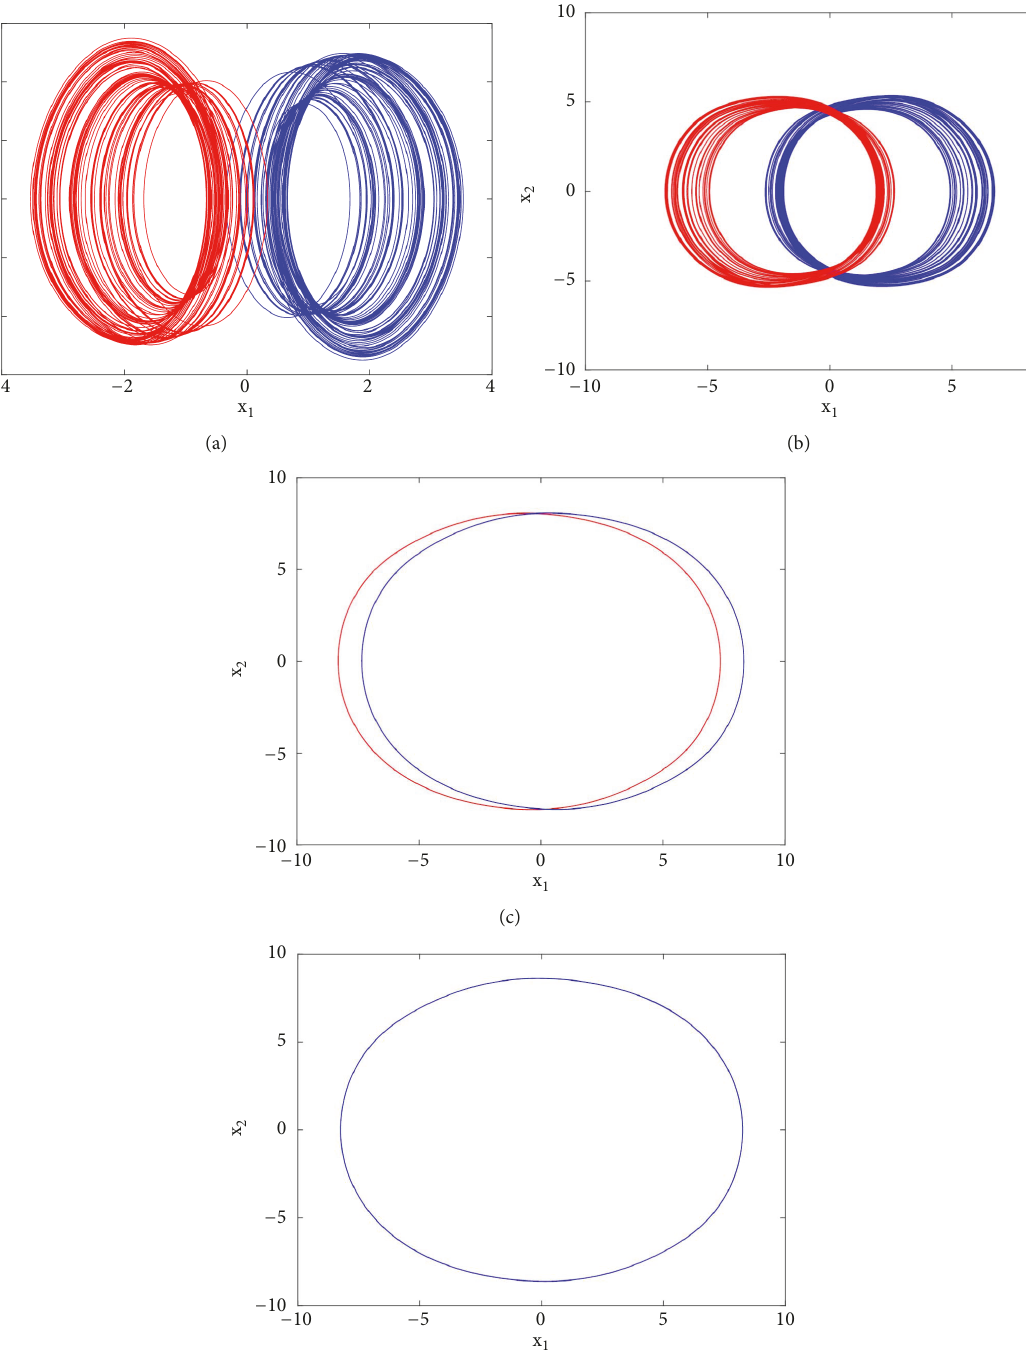
Figure 13: Coexistence of seven disconnected attractors (two pairs of chaotic attractors, a pair of period-1 limit cycle, and a symmetric period-1 limit cycle) for a 2 = 3 with the rest of system’s parameters as follows: b = a 1 = 3, a 0 = 1.75, a 3 = 1, a 4 = 0.0109. Initial states are given